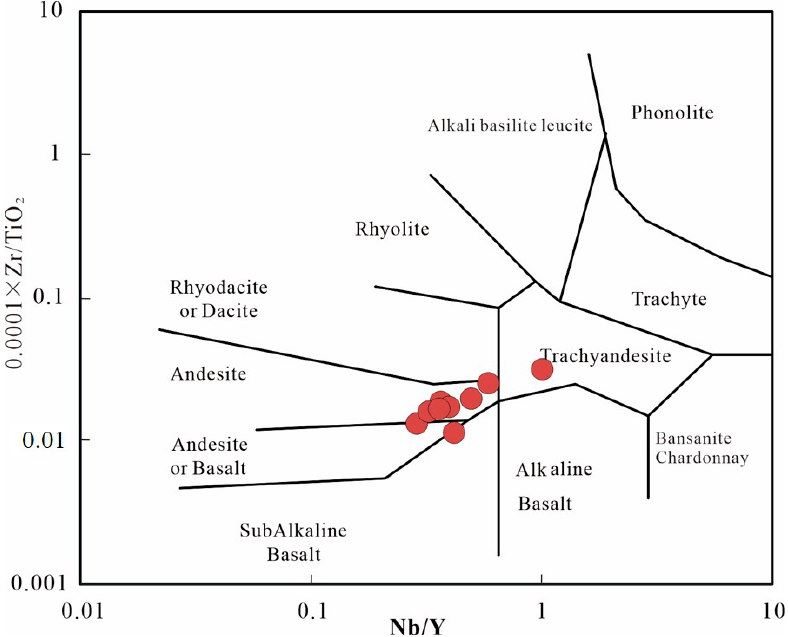
Figure 5. Plots of mafic volcanic rocks 0.0001 × Zr/TiO 2 versus Nb/Y diagram (modified after Winchester et al. [41]).